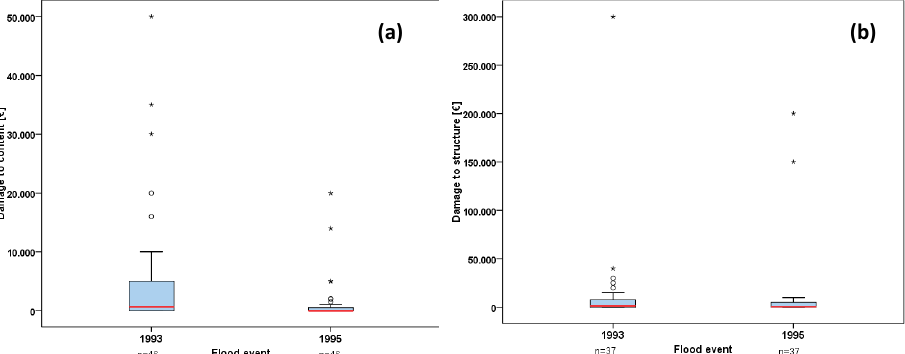
Figure 3: Box-whisker plots of damage to contents (a) and damage to structure (b) of respondents with close to 8 Fig. 3. Box whisker plots of (a) damage to contents and (b) damage to structure of respondents with close to identical water levels in the identical water levels in the cellar and ground floor in 1993 and 1995. 9 cellar and ground floor in 1993 and 1995. Note: Damage to contents and structure is significantly different (Wilcoxon signed-rank test) at the 1 per cent